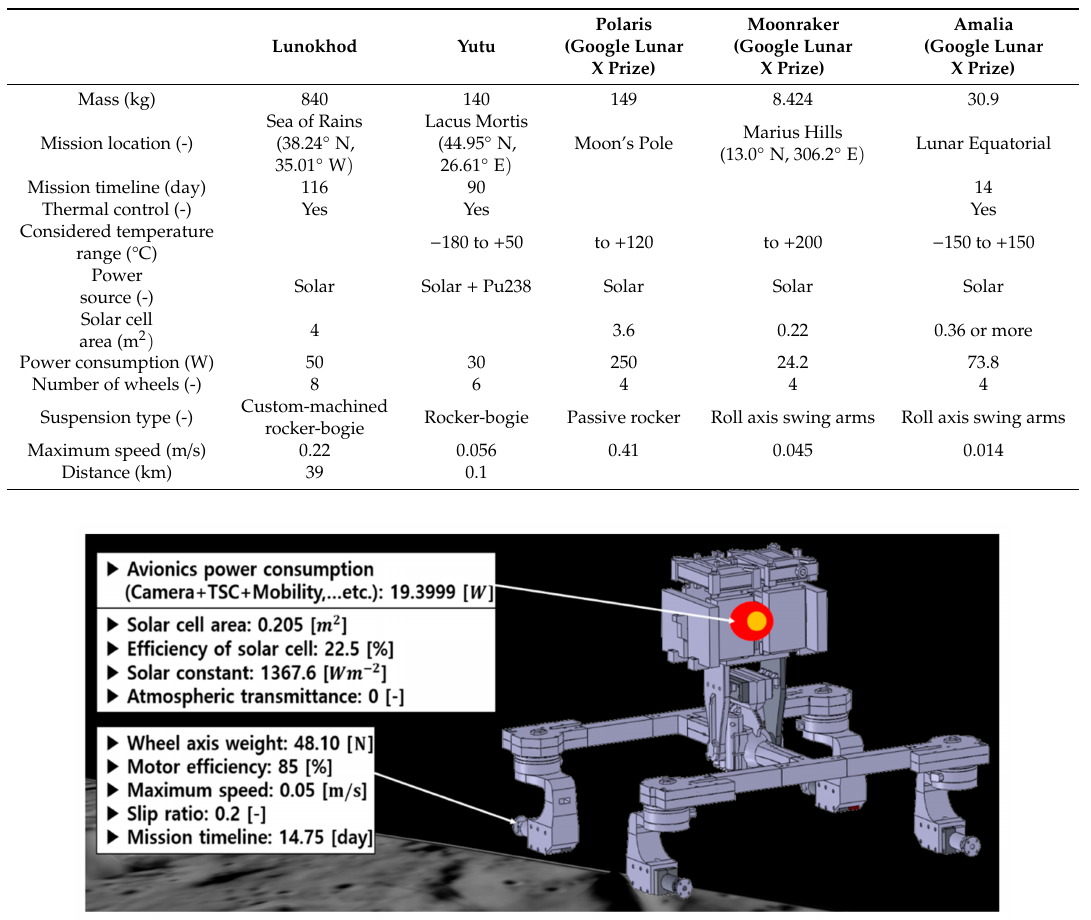
Table 2. Previously developed rovers for lunar exploration missions.